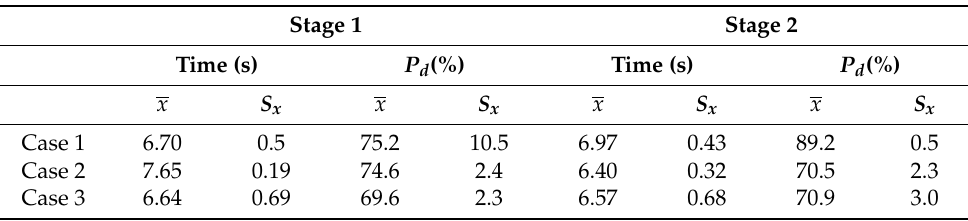
Table 6. Computational time and probability of damage existence: x —sample mean, S x —sample standard